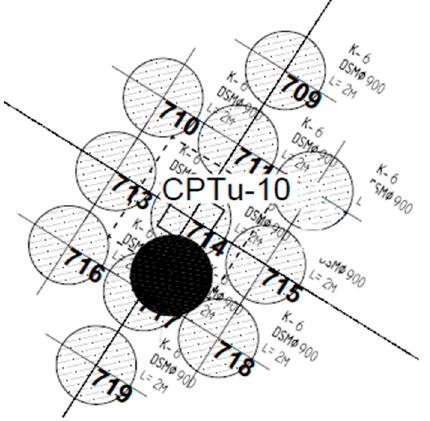
Figure 7. Group No. 2—made based on the representative column No. 714 and the results of the CPTU-10 probing.